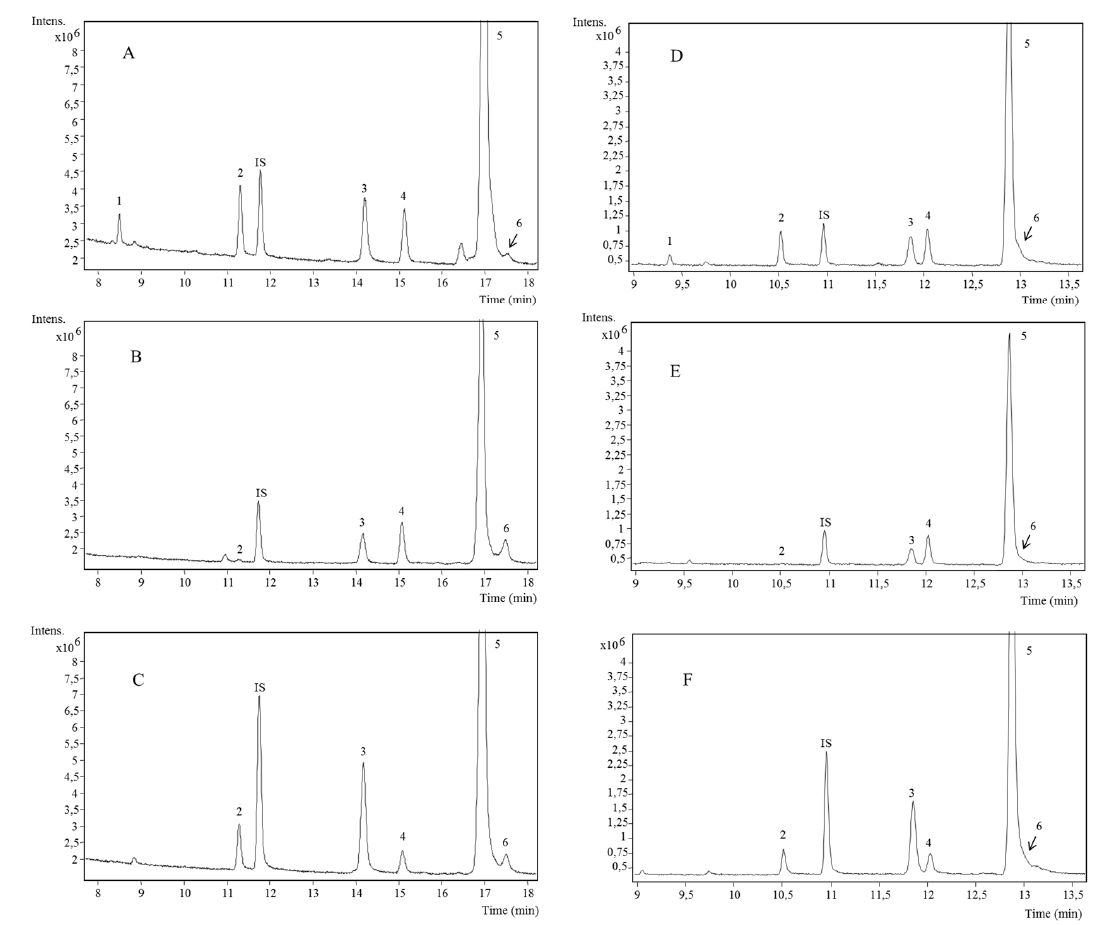
Figure 1. Total ion chromatograms of “Keitt” cultivar obtained using HP-5ms column ( A ) peel, ( B ) seed, ( C ) pulp and using RTX-200MS ( D ) peel, ( E ) seed, ( F ) pulp. See Table 3 for identification numbers. IS (internal standard).